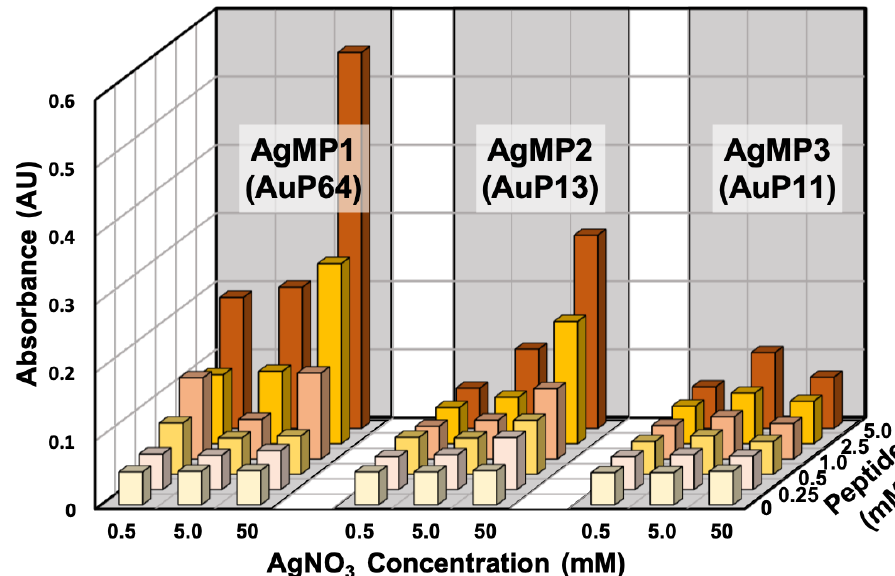
Figure 2. Silver nanoparticle (AgNP) synthesis using the top three (TOP3) screened peptides (AgMP1, AgMP2, and AgMP3) from the peptide array. Mineralization was evaluated based on absorbance intensity (450 nm) in the presence of di ff erent concentrations of peptides (0, 0.25, 0.5, 1.0, 2.5, and 5.0 mM) and AgNO 3 (0.5, 5.0, and 50 mM).